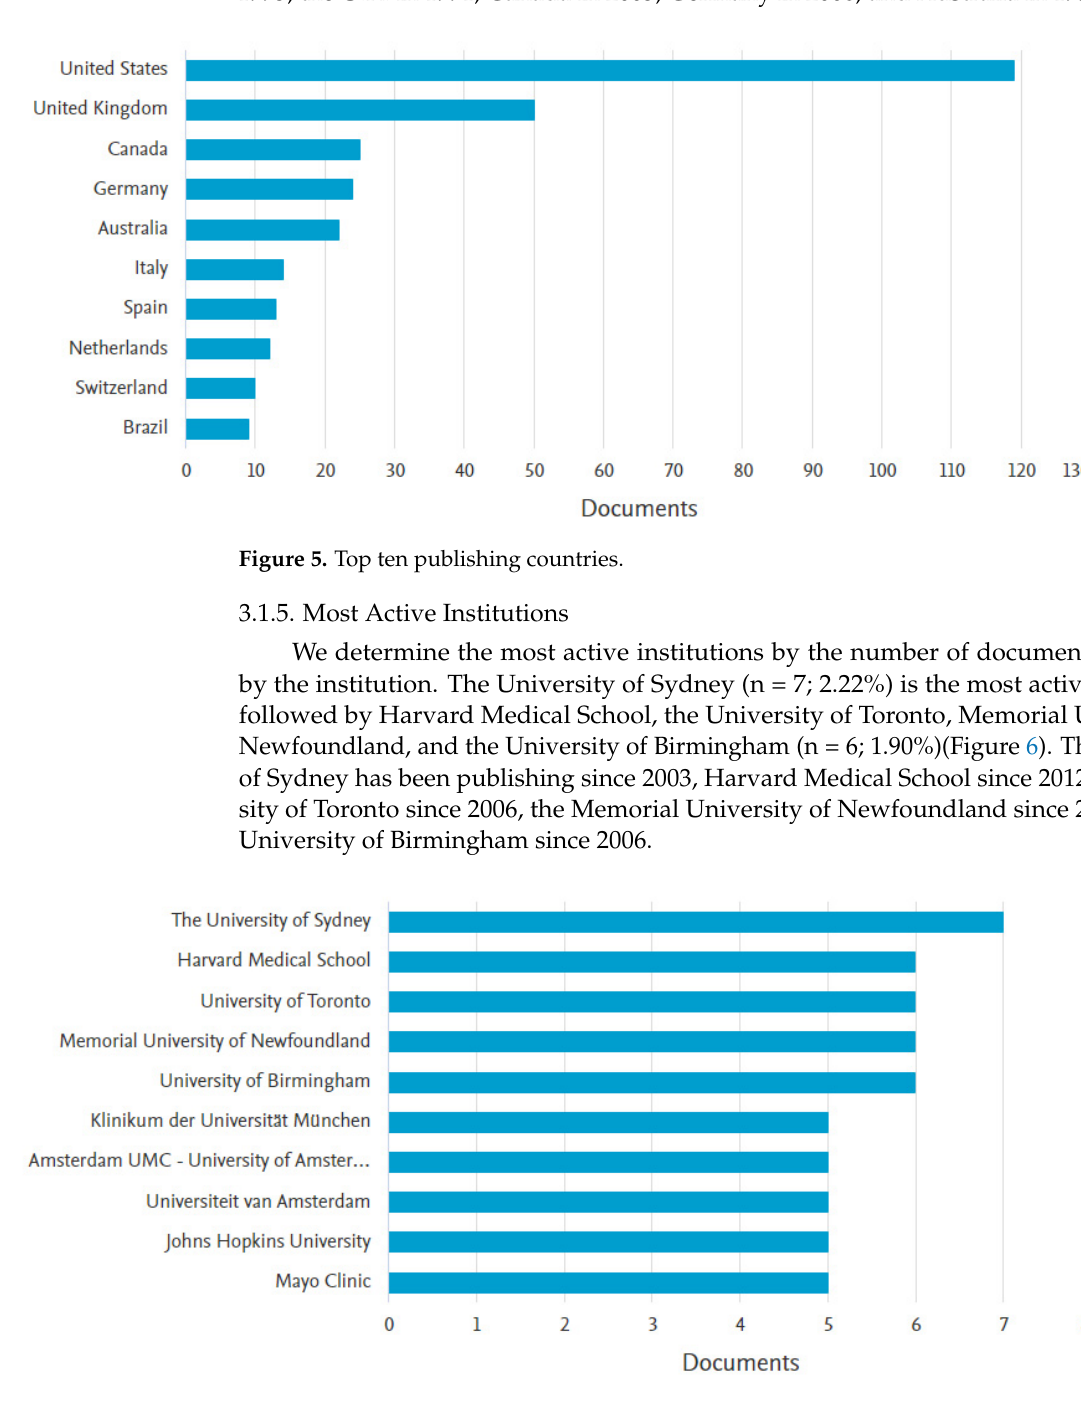
Figure 6. Top ten most active institutions.